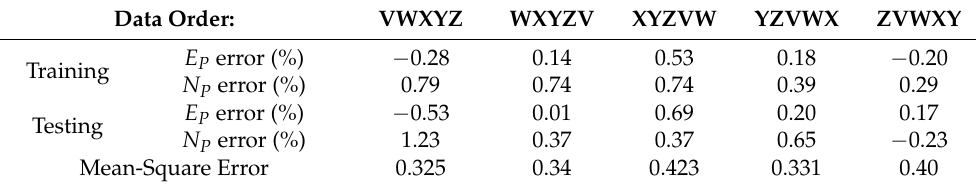
Figure 6. LPPM training. ( a ) MSE. ( b ) Regression results.